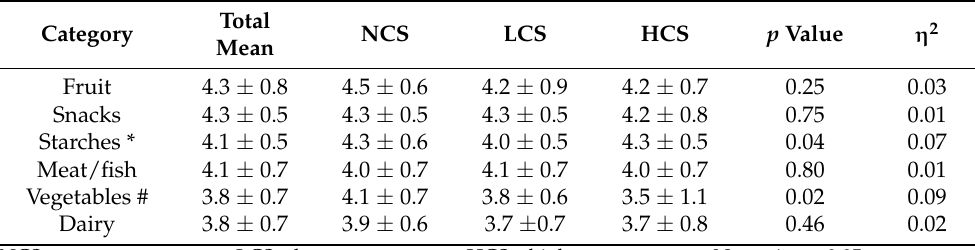
Table 2. Food preference questionnaire results.